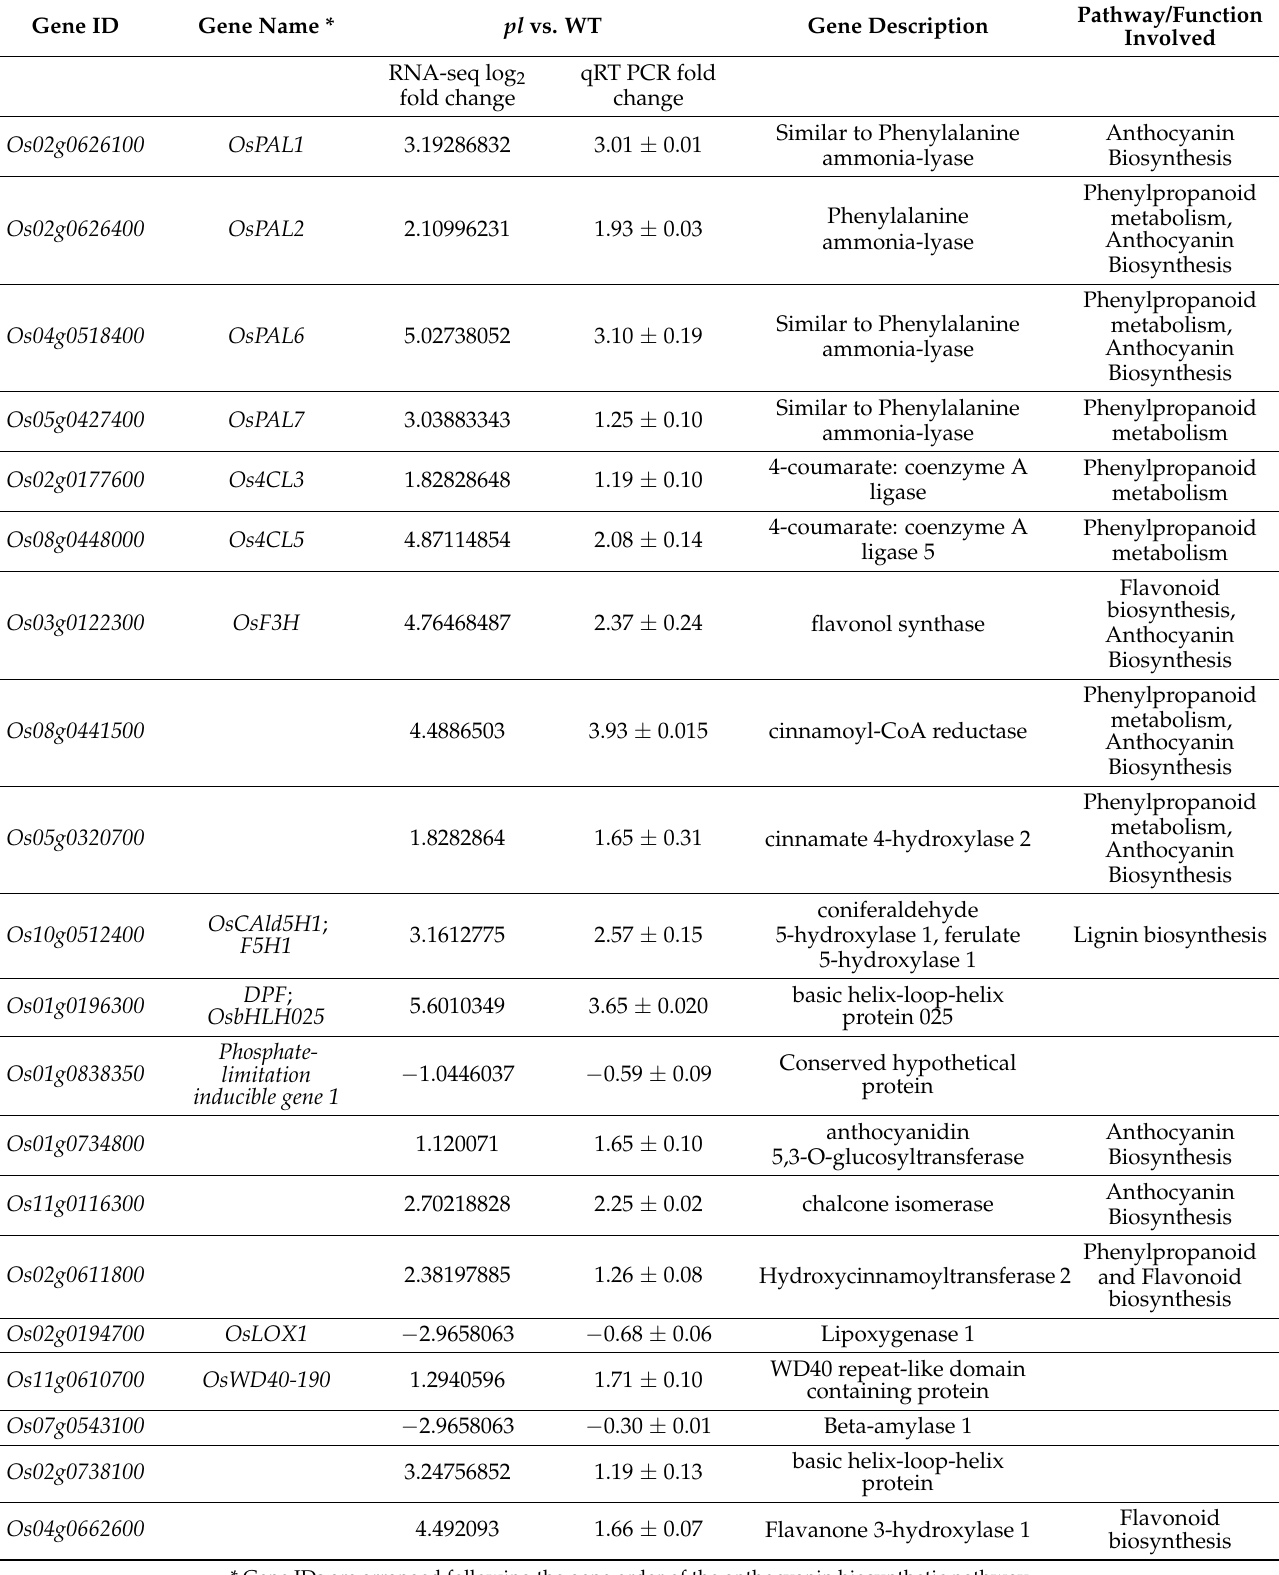
Table 3. Relative gene expression analysis of 20 randomly selected genes for making the comparison of pl and WT group conducted by RNA- seq and qRT